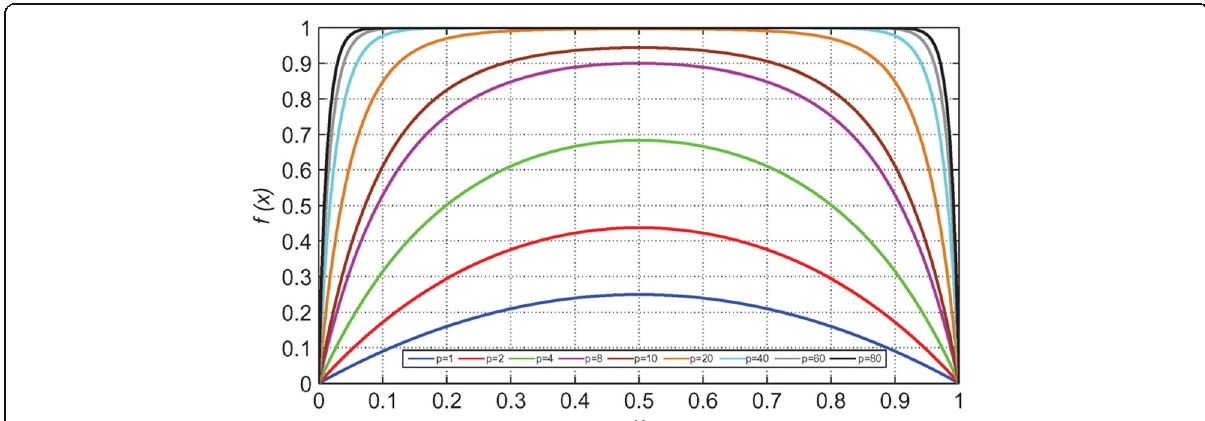
Fig. 22 Plot of the proposed window function f ( x ) = 1 − [( x − 0.5)2 + 0.75] p against the normalized width of the doped region x ( p is considered as a variable)